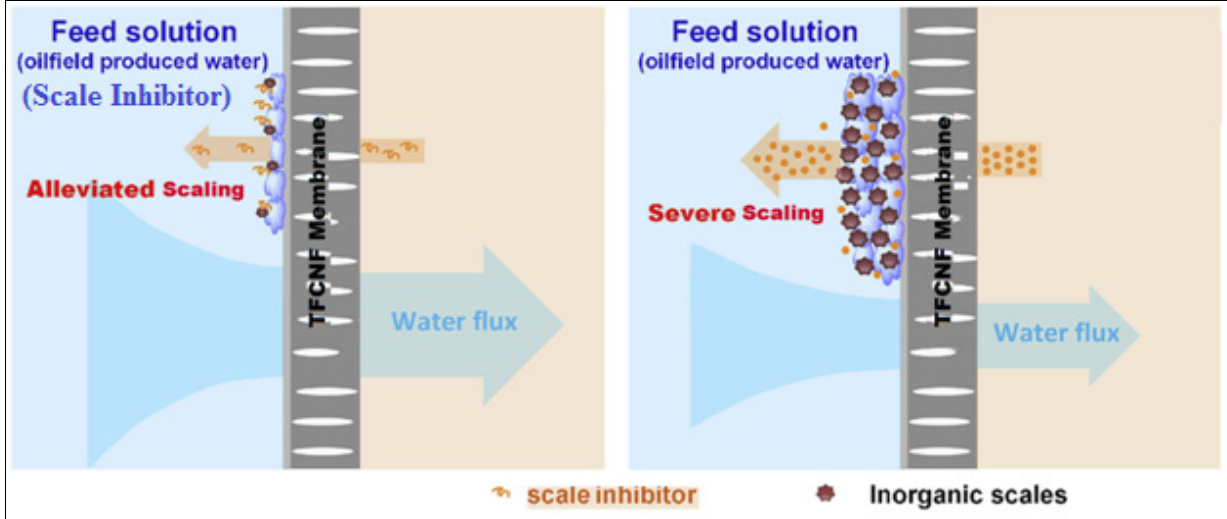
Figure 15. TFCNF membrane mechanism for reduced calcite with and without scale inhibitors in oilfield produced water.